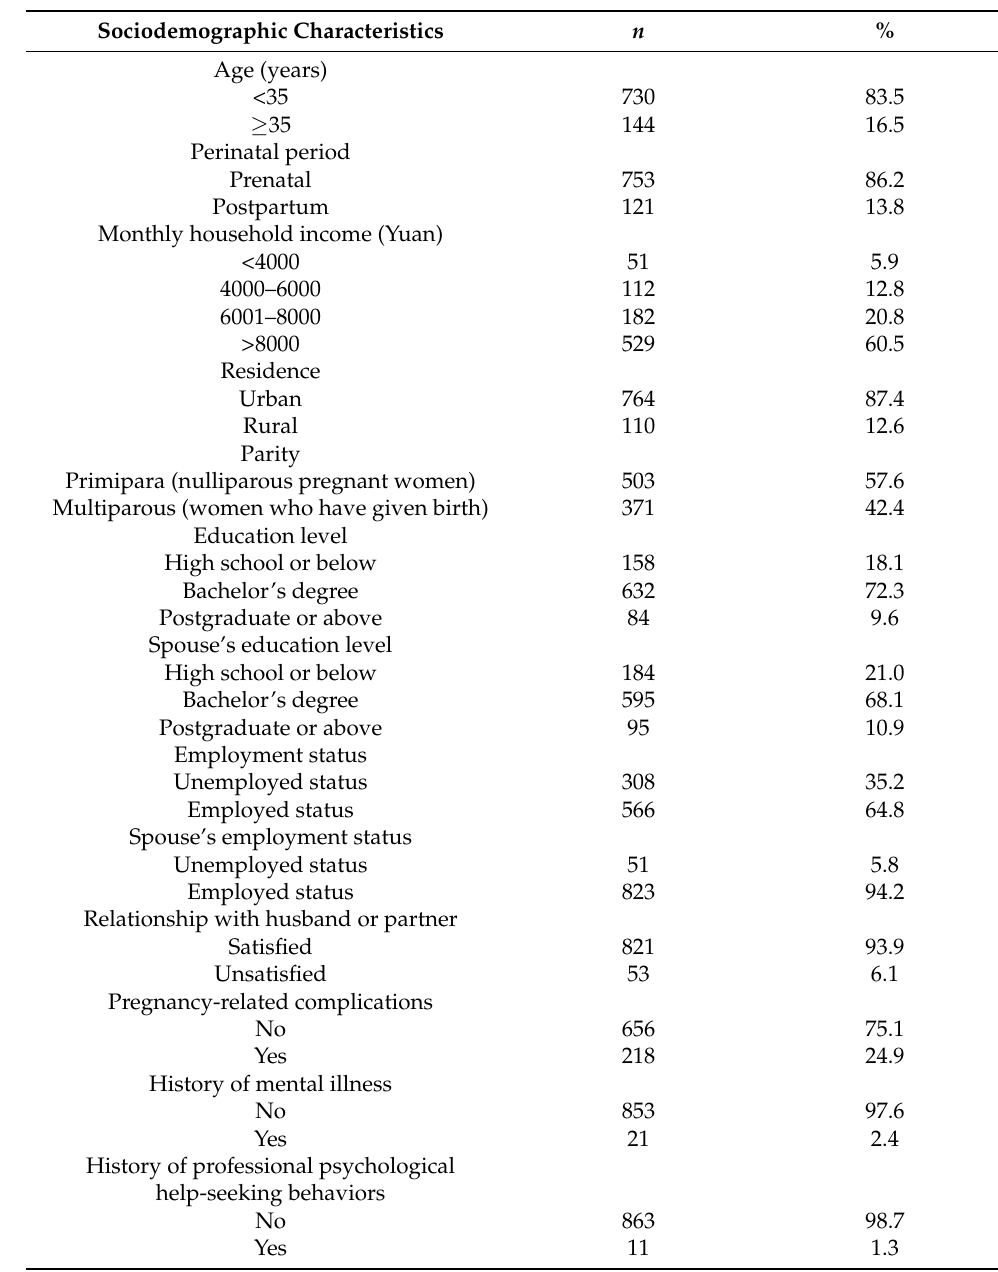
Table 1. The characteristics of participants ( n =